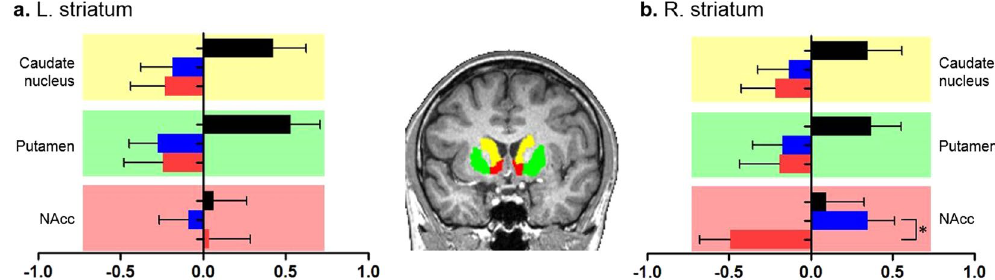
Figure 2. Comparisons of the standardized striatal volumes among the Internet gaming disorder (IGD), Internet gaming control (IGC), and non-gaming control (NGC) groups. ( a , b ) Although the volumes of the bilateral caudate nucleus and putamen were not significantly different among three groups, ( b ) the volume in the right nucleus accumbens (NAcc) was different, which was driven by the smaller volume in the IGD group than that in the IGC group, adjusting for age and the estimated total intracranial volume (eTIV). In the brain image, each color represents a brain region (yellow: the caudate nucleus, green: putamen, red: nucleus accumbens). The colors of the bar graphs indicate the following: black, NGC group; blue, IGC group; red, IGD group. The outputs of the striatal areas, which were obtained from FreeSurfer, are overlaid on the brain image of a subject. * Significant at P < 0.05.